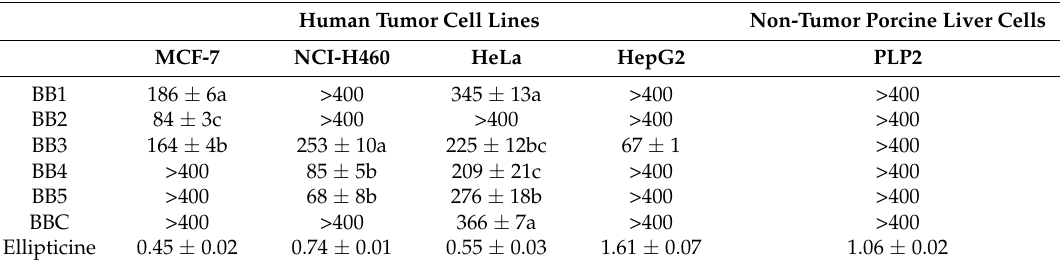
Table 3. Cytotoxic activity (GI 25 values, µ g/mL) of the bee bread (BB) samples. Human Tumor Cell Lines Non-Tumor Porcine Liver Cells